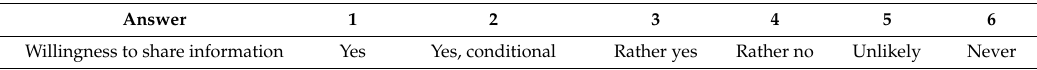
Table 1. Strength of preference for sharing information with insurance company.